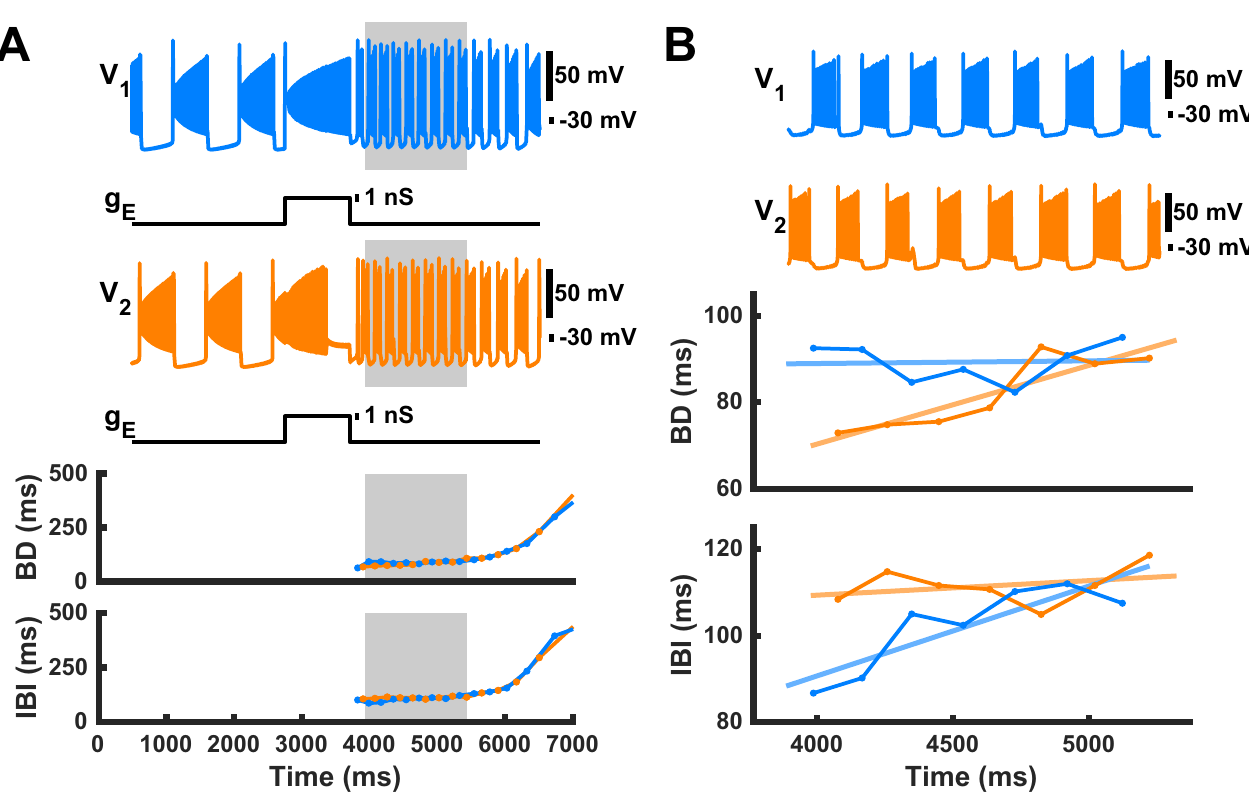
Fig 3. Example of burst duration (BD) and interburst interval duration (IBI) progressions throughout transient paw-shake-like activity. The membrane potential, BD, and IBI of neurons #1 and #2 are depicted in blue and orange, respectively. (A) Revisiting the example from Fig 1, where the gray region indicates transient paw-shake-like activity. (B) Zooming in on the gray region from panel A , we see that BD 2 (orange lines) and IBI 1 (blue lines) increase, while BD 1 (blue lines) and IBI 2 (orange lines) remain roughly